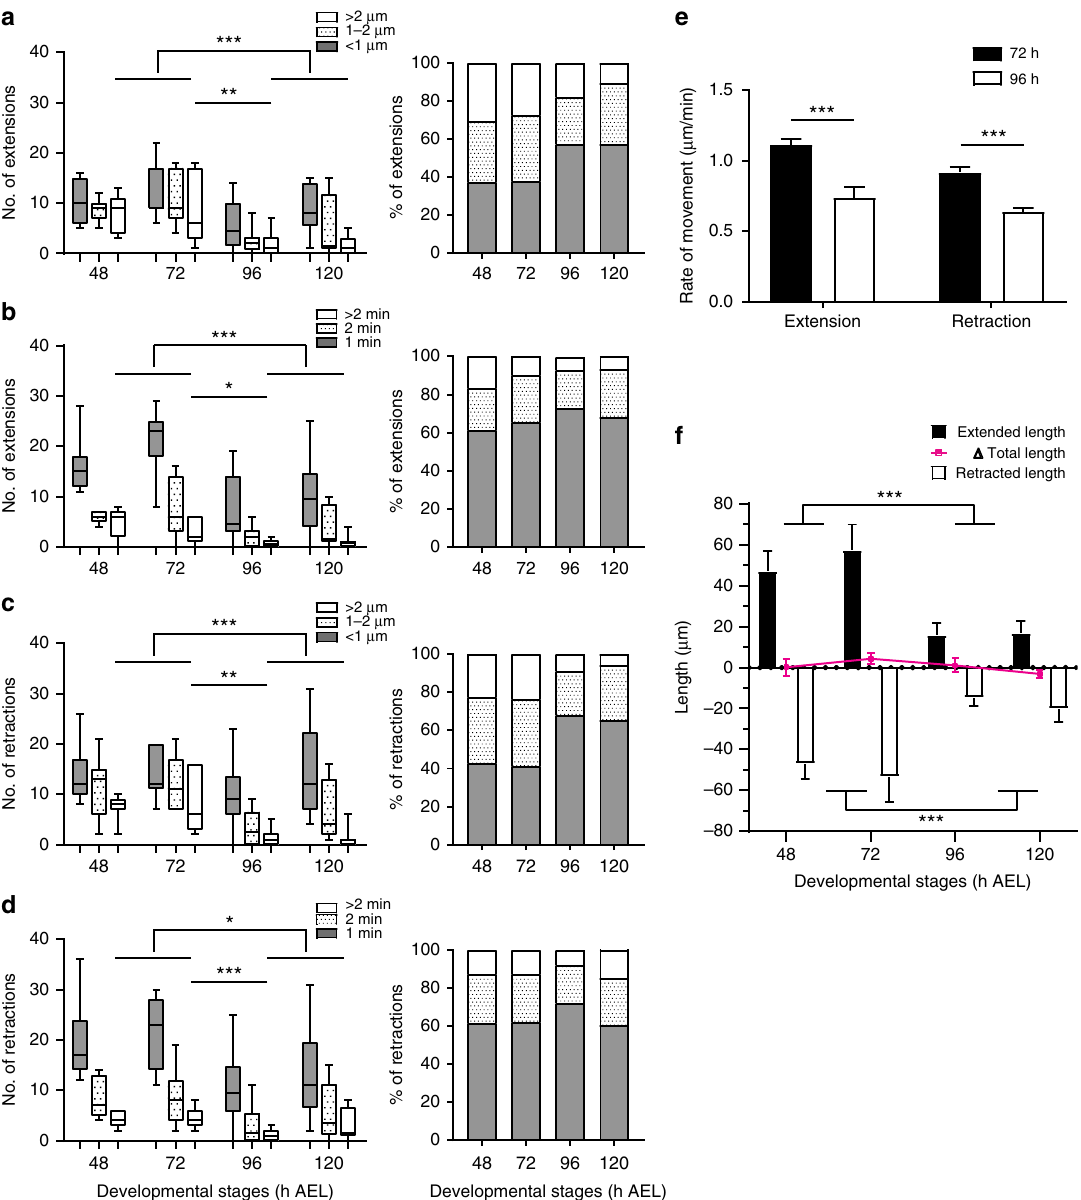
Fig. 2 LNv dendrites change from dynamic to stable during development. a , b At all stages, most extensions are within 2 μ m or lasted less than 2 min. More extension events that last longer than 2 min or travel further than 2 μ m were observed in young neurons as compared to mature neurons. Distributions of distance and duration are shown. c , d Retractions behave similarly as extensions. Statistical signi fi cance was assessed by two-tailed Student ’ s t -test for extensions/retractions with distance more than 2 μ m or duration more than 2 min. a P < 0.001, 2 nd vs 3 rd instar; P = 0.008, 72 vs 96 h. b P < 0.001, 2 nd vs 3 rd instar; P = 0.018, 72 vs 96 h. c P < 0.001, 2 nd vs 3 rd instar; P = 0.004, 72 vs 96 h. d P = 0.011, 2 nd vs 3 rd instar; P = 0.001, 72 vs 96 h. e Dendrites in young LNvs (72 h) extend and retract faster than the ones in mature LNvs (96 h). Statistical signi fi cance was assessed by sum-of-squares F test of slopes generated by linear fi tting of the distance vs. duration. For extension: slope is 1.113 ± 0.044 for 72 h, and 0.738 ± 0.075 for 96 h. For retraction: slope is − 0.917 ± 0.037 for 72 h, and − 0.639 ± 0.025 for 96 h; P < 0.001 for both comparisons. n = 11, 72 h; n = 13, 96 h. f Cumulatively, young neurons (48 and 72 h) extend and retract signi fi cantly more than mature neurons (96 and 120 h), without affecting the total dendritic length. Statistical signi fi cance was assessed by two-tailed Student ’ s t -test. Extended length: P < 0.001; retracted length: P < 0.001. n = 7, 7, 10, and 8 for 48, 72, 96, and 120 h, respectively, for a – d , and f . Data are presented as box plot (box, 25 – 75%; center line, median) for a – d ; Bar heights are means and error bars are SEM in e – f ; ns, not signi fi cant; *P < 0.05, **P < 0.01, ***P <